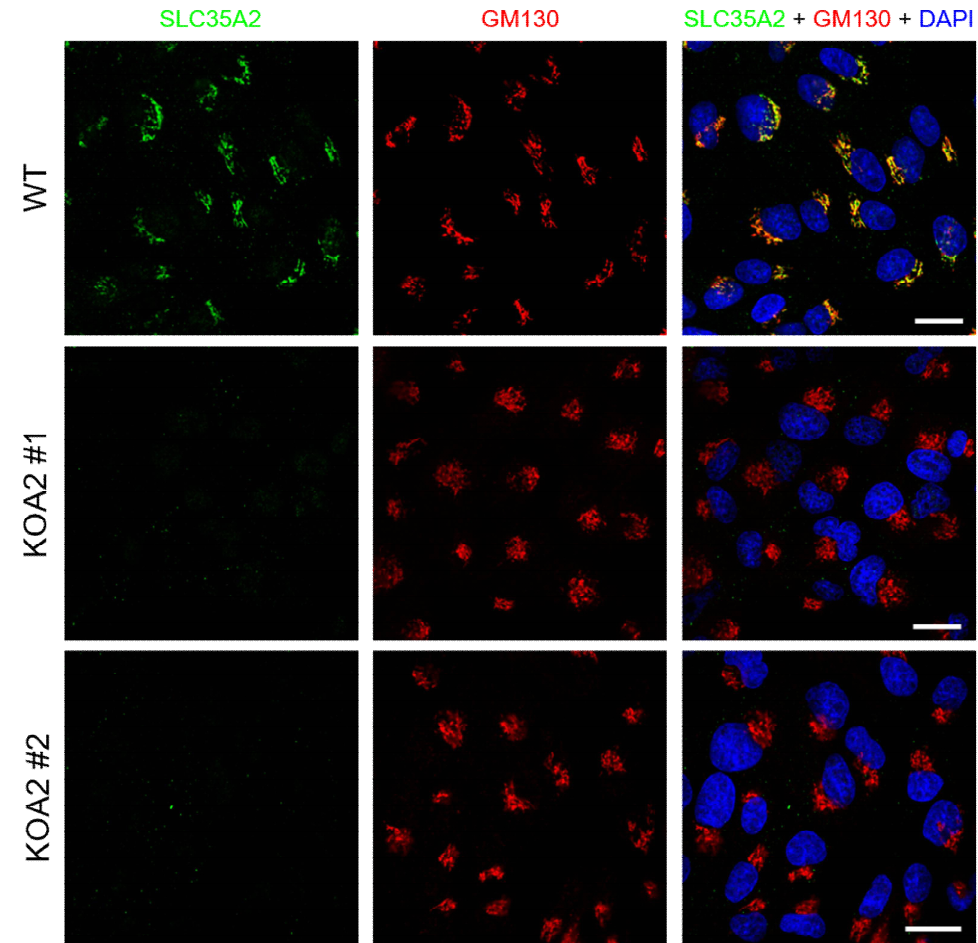
Figure 1. Confirmation of SLC35A2 knockout in the selected MDCK clones by immunofluorescence staining. SLC35A2 is shown in green, GM130 is shown in red, and cell nuclei are shown in blue. Scale bar corresponds to 20 μm.